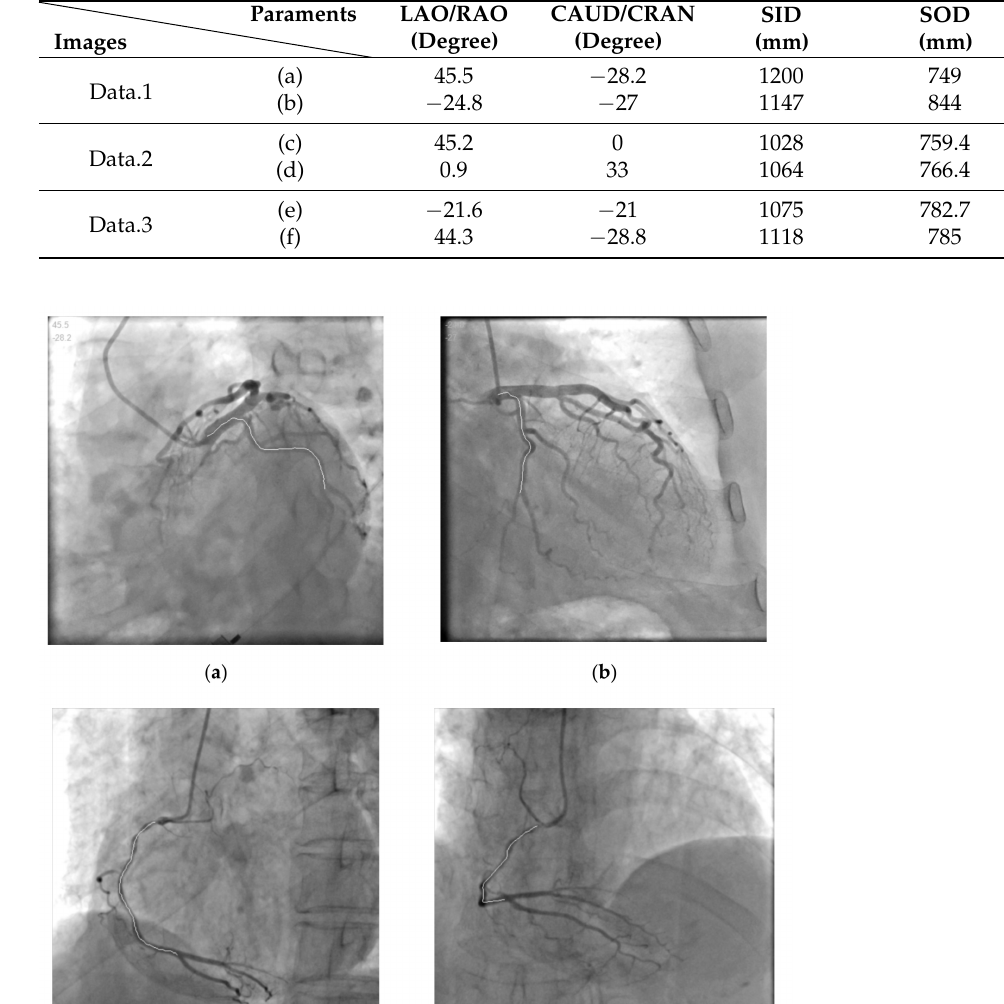
Table 1. Paraments of different datasets.